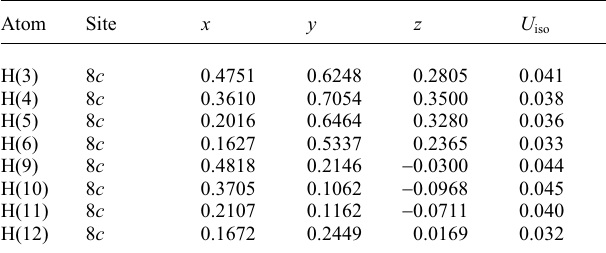
Table 2. Atomic coordinates and displacement parameters (in Å 2 )